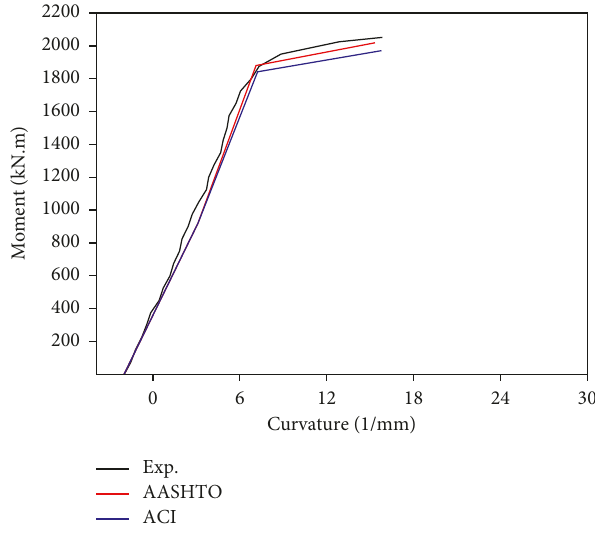
Figure 13: Moment–curvature for control girder